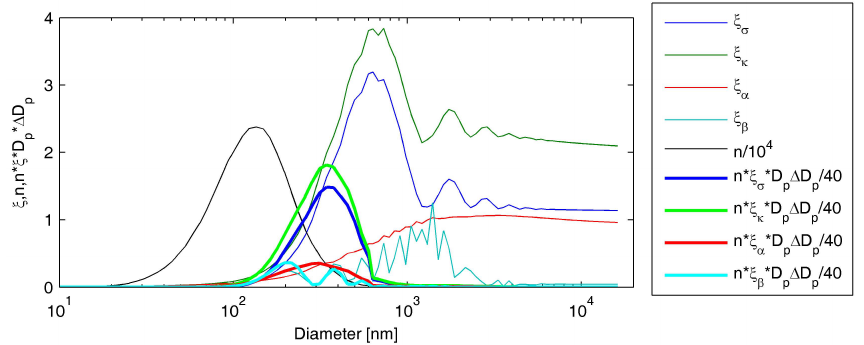
Fig. 1. Efficiency – ξ (for scattering – σ , extinction – κ , absorption – α and backscattering – β) , particle number concentration ( n = d N /dlog D p ) and the contributions to scattering, extinction, absorption, and backscattering ( n · ξ · D p · 1D p ) for each diameter ( λ = 550nm). n was recorded on 10 February 2008, 05:00